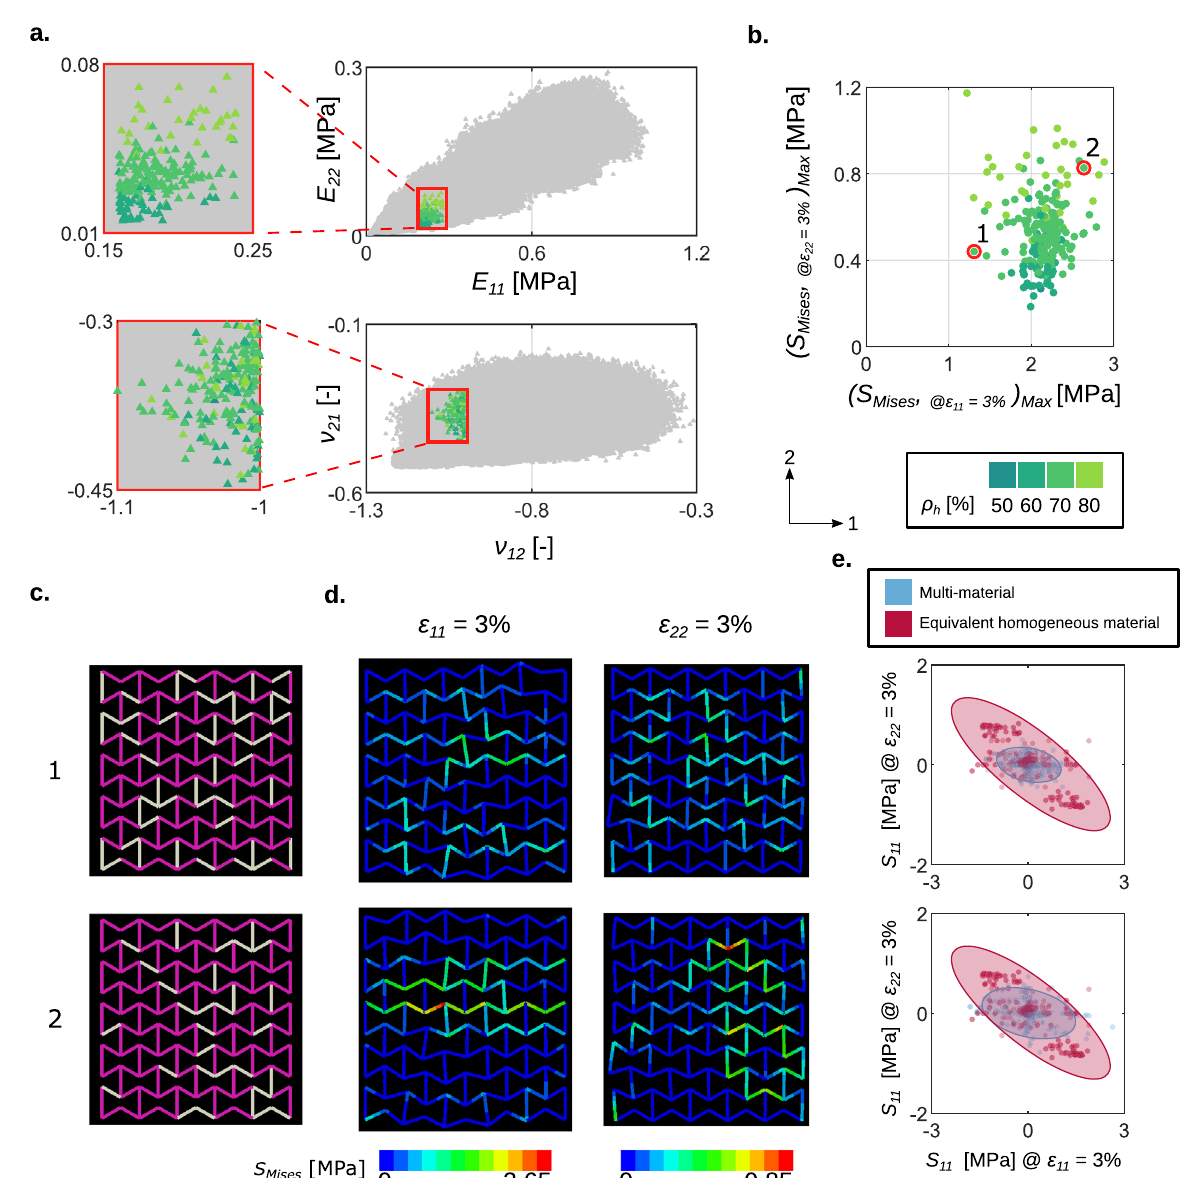
Fig. 4 Stress distribution within the lattice structure. a The selection of a certain range of the elastic properties achieved for the unit cells with a cell angle of 60 (cid:1) . In total, the elastic properties of 207 designs with various ρ values (i.e., 50%, 60%, 70% and 80%) fall within these selected ranges. b The h maximum values of the von Mises stress in the structural elements of the corresponding lattice structures when these structures were subjected to two boundary conditions (i.e., ε 11 ¼ 3 % or ε 22 ¼ 3 % ). Two designs were selected, including one with the minimum (node 1) and one (node 2) with the maximum Eu c lidean distance from the origin ( b , c ). The distribution of the von Mises stresses in the selected designs and their deformations under two boundary conditions (i.e., ε 11 ¼ 3 % or ε 22 ¼ 3 % ) are presented in ( d ). The axial stresses ( S 11 ) in the struts of each design under two boundary conditions (i.e., ε 11 ¼ 3 % or ε 22 ¼ 3 % ) are calculated and are compared with the axial stresses of the corresponding struts when the lattice structure is composed of an equivalent homogenous material ( e